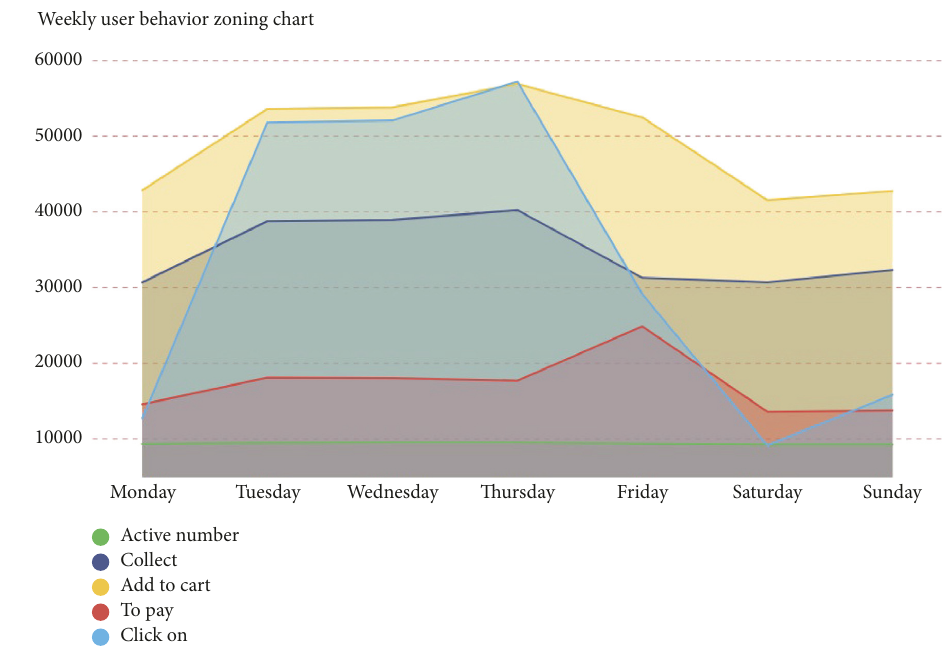
Figure 15: Daily retention